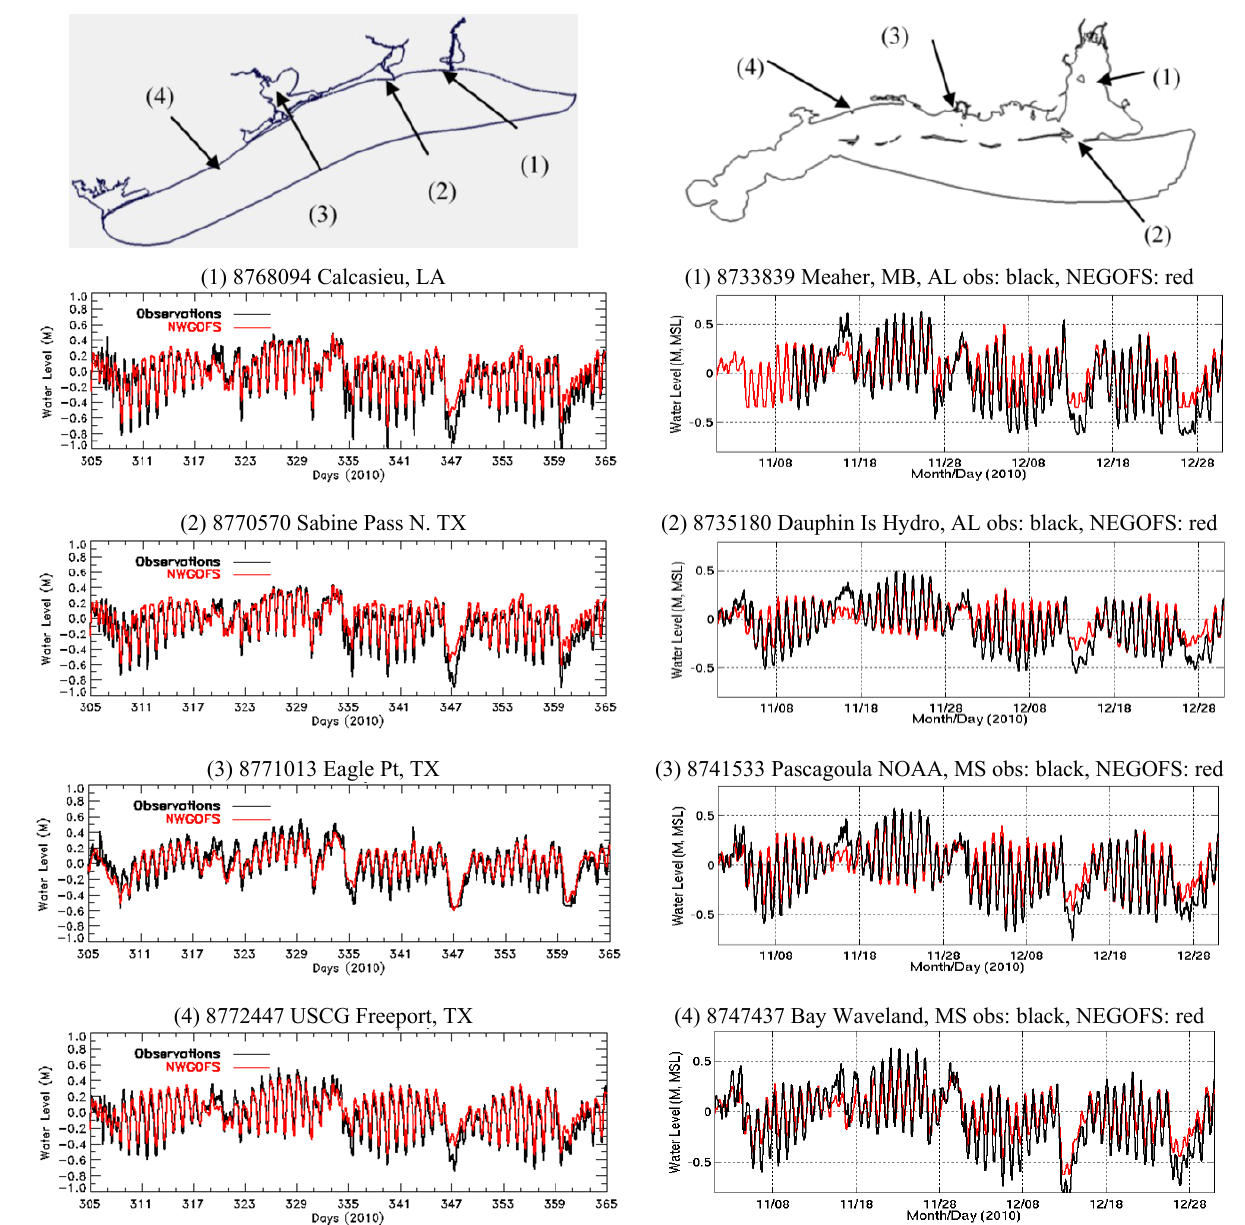
(gp0401, Figure 9, right column). At the Mobile Bay entrance (mb0101), the model underestimated the peak tidal current speed. Figure 7. Simulated (red) and observed (black) water level time series at stations in NWGOFS (left column) and NEGOFS (right column) from 1 November 2010 to 31 December